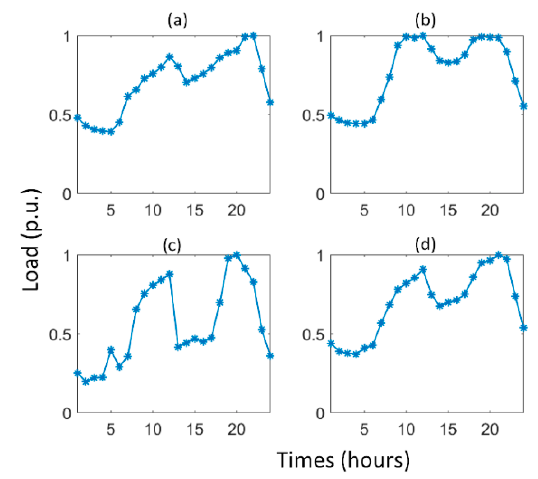
Figure 3. Illustration of three load curves ( a – c ) and integrated one ( d ).